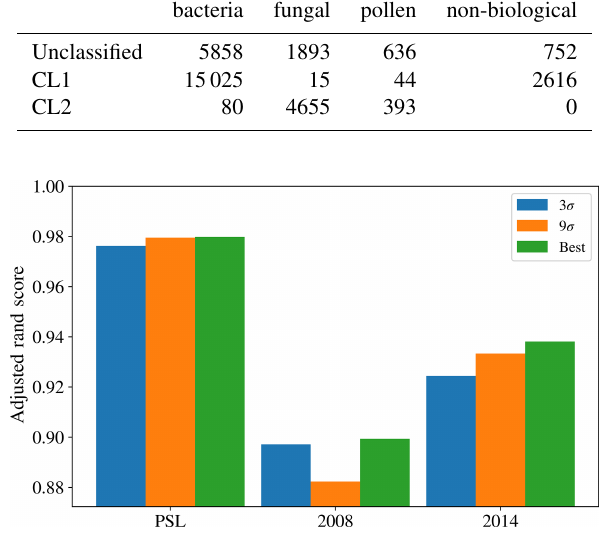
Figure 15. Performance of gradient boosting for the different data sets when using 3 σ and 9 σ